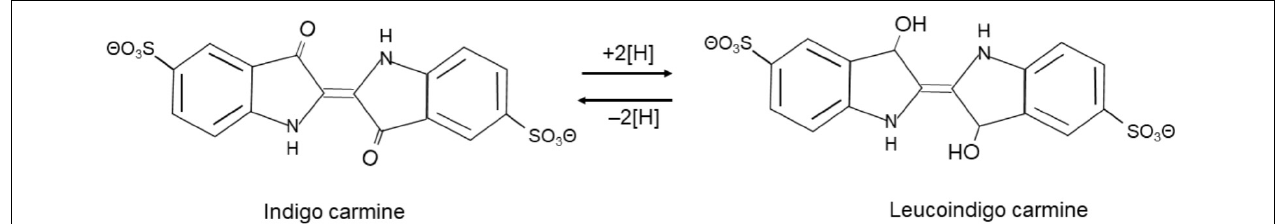
FIGURE 3 | Chemical structure of indigo carmine and its